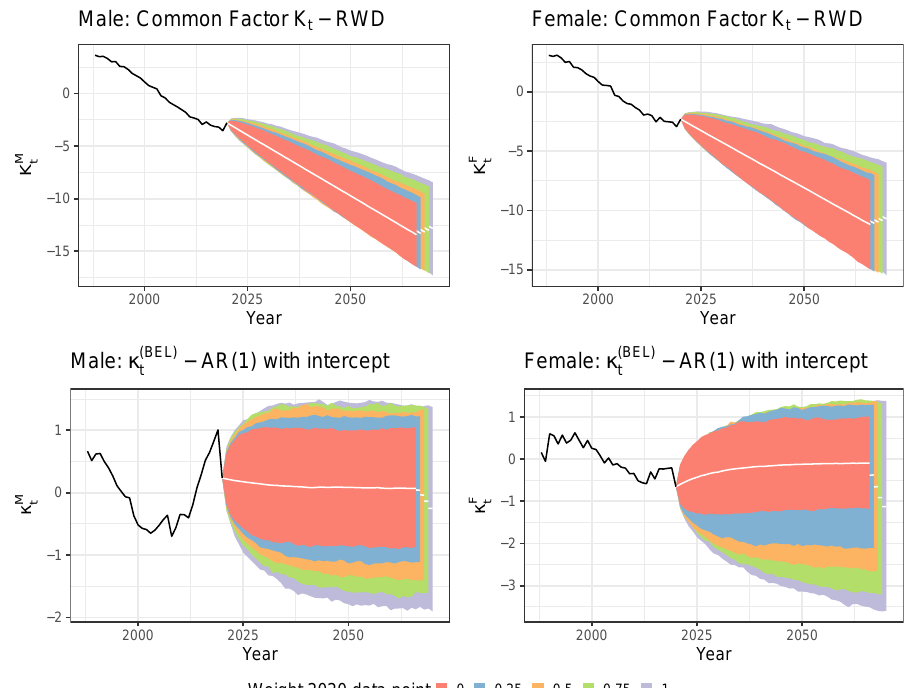
Figure 8. Projection of the calibrated time dependent parameters in the Li and Lee model: ˆ K t ( top ) and ˆ κ t ( bottom ). Male ( left ) and female ( right ) data, calibration period 1988–2020, projection period 2021–2070, method of Section 5.1. We show the 0.5%, median (white lines) and 99.5% quantile, based on 10,000 simulations across each weighting scenario. The black lines visualize the calibrated period effects: ˆ K t and ˆ κ t